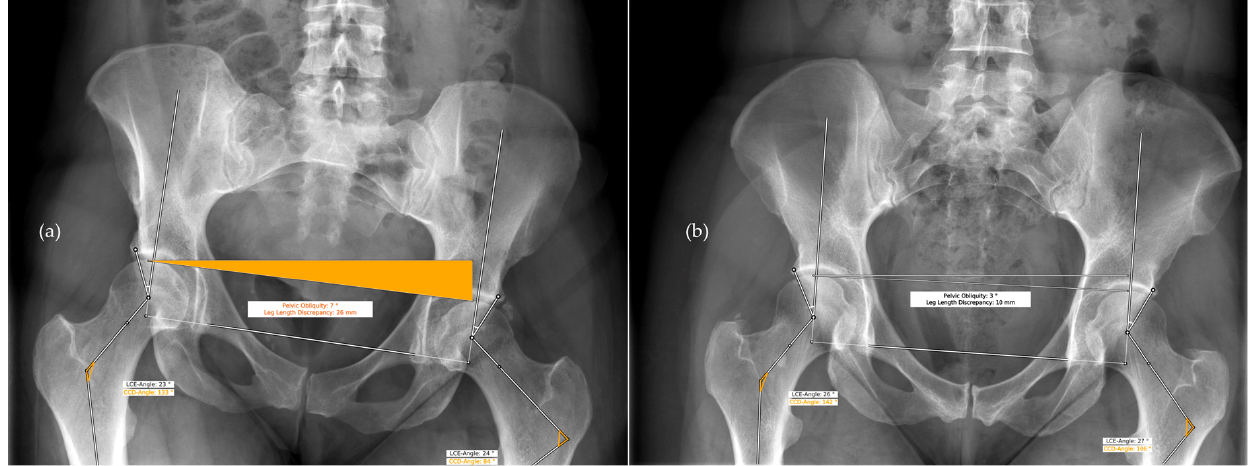
Figure 4. HIPPO™ erroneous reports of two AP radiographs of the pelvis that were identified as outliers. ( a ) Pelvic obliquity resulted in a cropped proximal femur and the anatomical femur axis could not be identified correctly. ( b ) The proximal femur is barely visible and the anatomical femur axis could not be identified correctly.